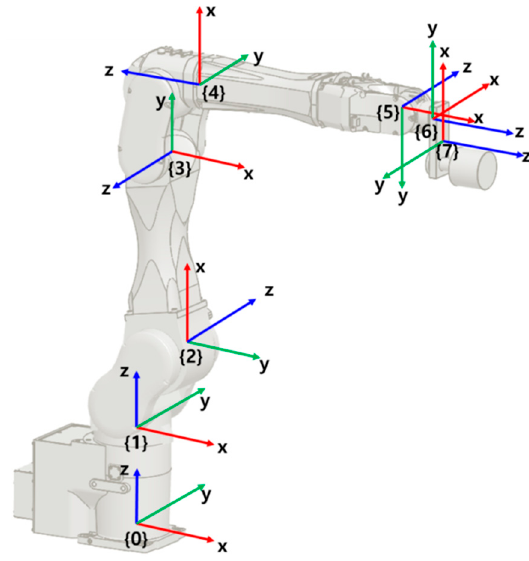
Figure 1. 6-DoF industrial robot.